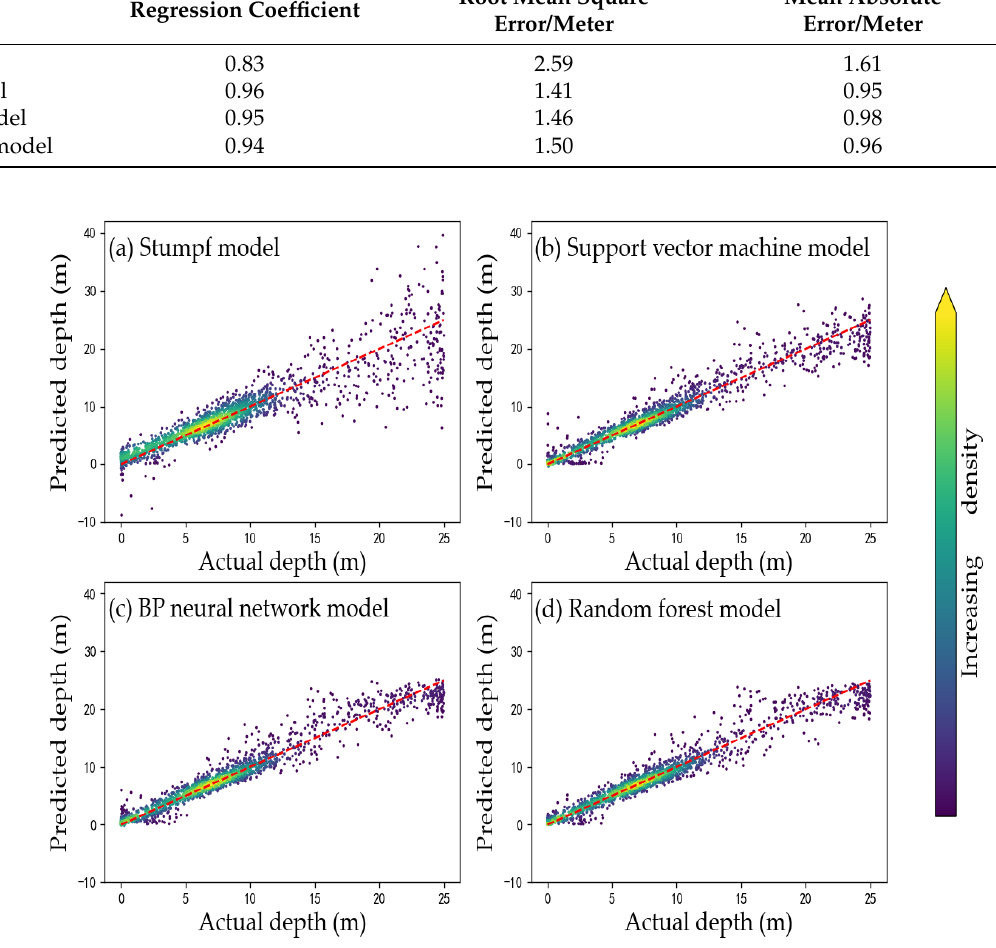
Figure 4. ( a - d ) Scatter diagram of water depth inversion values and measured